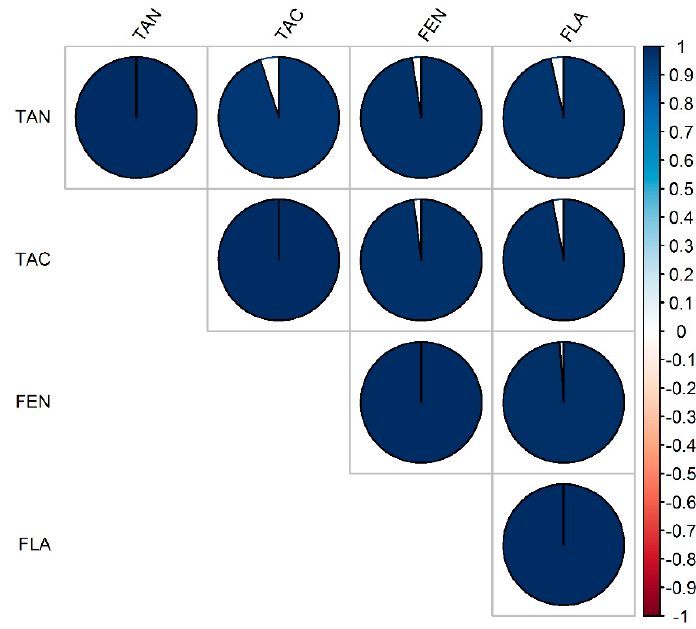
Figure 2. Pearson correlation coefficients among the evaluated traits. FEN, FLA, TAC, TAN, respectively, polyphenols, flavonoids, total antioxidant capacity, and condensed tannins. The filled-in areas of the circles show the absolute value of corresponding correlation coefficients. The scale on the right-hand side is colored from red (negative correlation) to blue (positive correlation); with the intensity of color scaled 0–100% in proportion to the magnitude of the correlation. Table 1. Mean (estimate) and standard deviation (estimated error) of the posterior distributions, and the quantile-based confidence intervals Traits